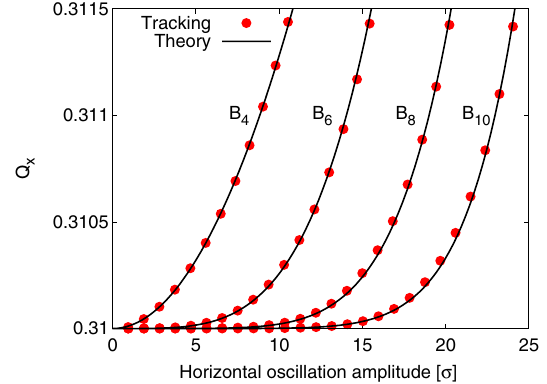
FIG. 1. Direct term of amplitude detuning for a single multi- pole of order 2 n . The red dots are the result of the tracking and the black lines are the theoretical predictions for an ac dipole excitation (free oscillations term corrected by n ).